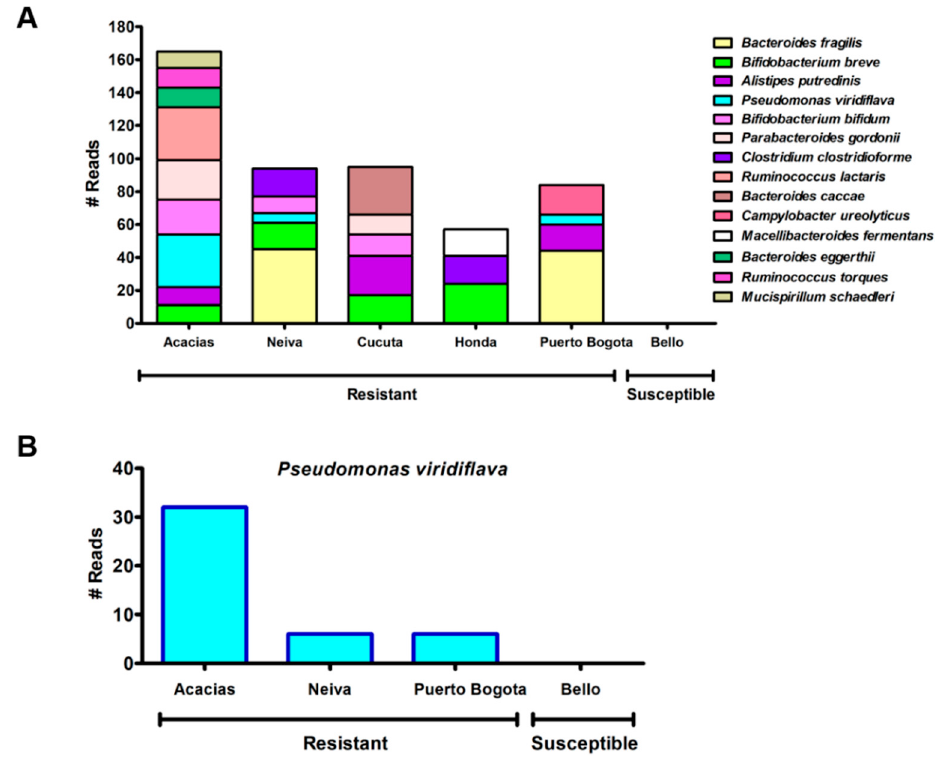
Figure 8. The number of reads for species present only in lambda-cyhalothrin resistant populations from Colombia. ( A ) Comparison of the number of reads per species present only in lambda-cyhalothrin resistant mosquitoes from six localities. ( B ) The number of reads for Pseudomonas viridiflava present only in Acacias, Neiva, and Puerto Bogota.